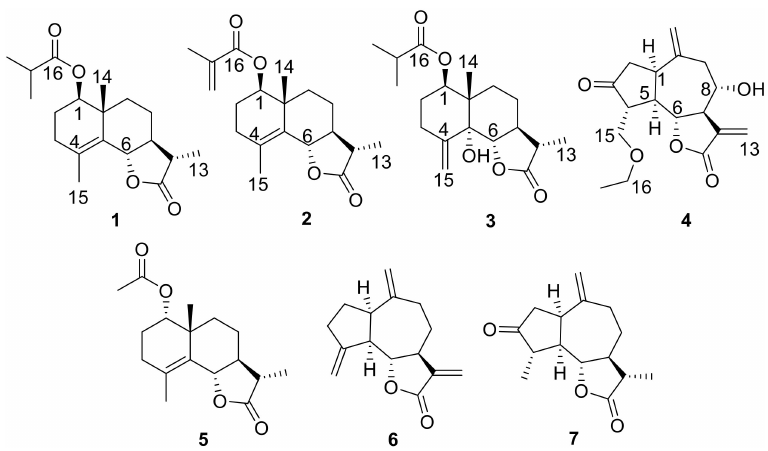
Figure 1. Structures of sesquiterpenoids 1 – 7 from Artemisia vestita